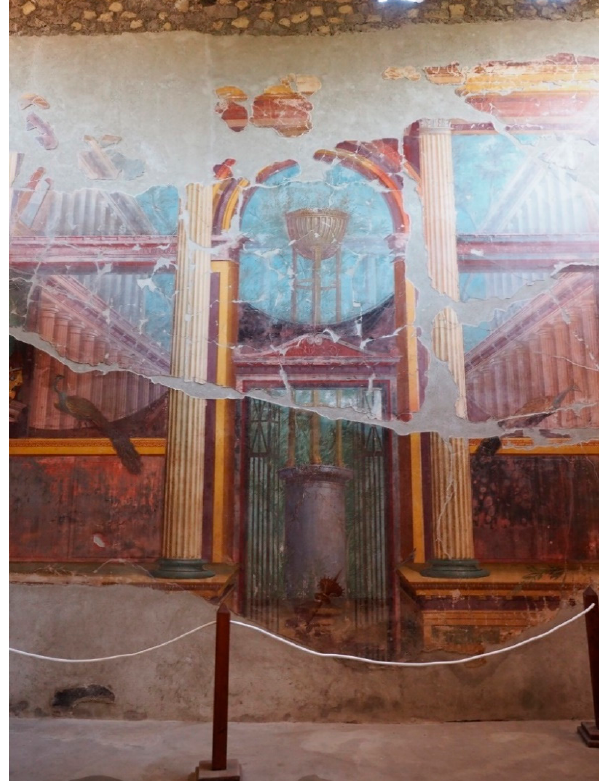
Figure 8. Wall decorated in second style in oecus 15 from the Villa A of Oplontis; © photograph by author.